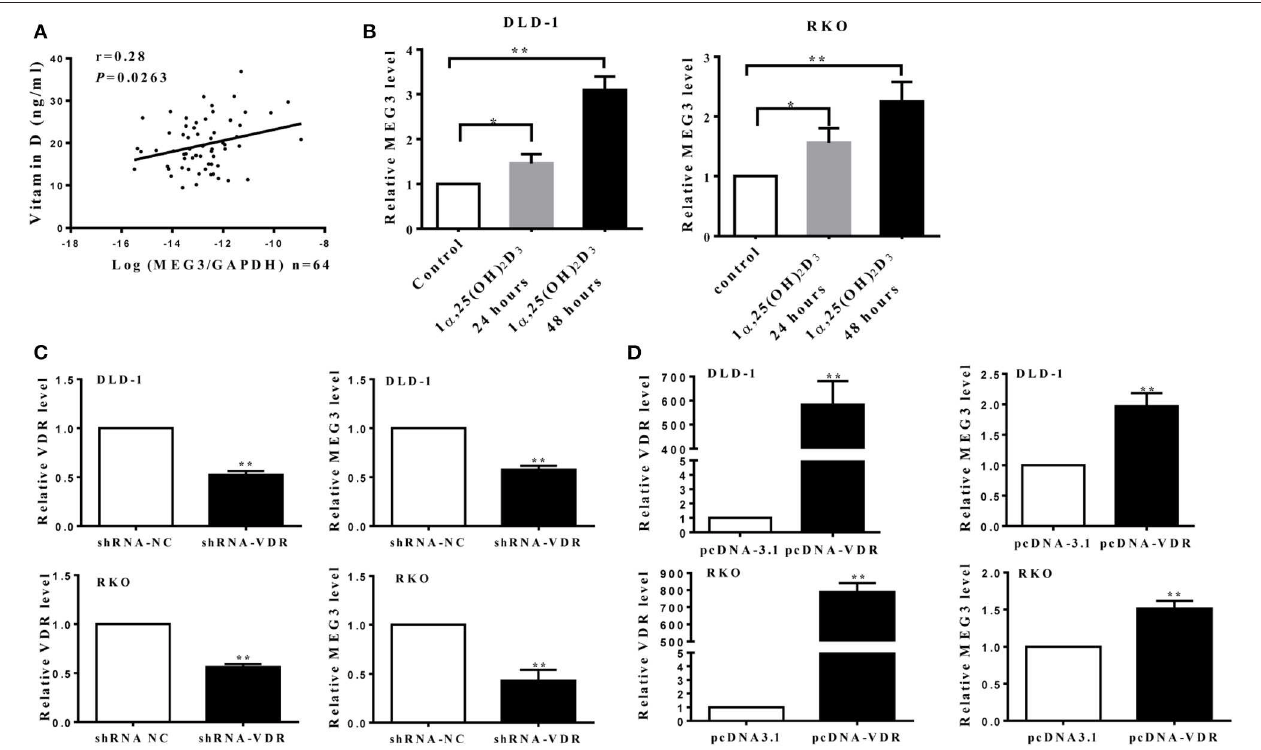
FIGURE 5 | Maternally expressed gene 3 ( MEG3 ) is activated by vitamin D through vitamin D receptor (VDR). (A) Levels of MEG3 expression in colorectal cancer (CRC) tissues and serum concentrations of vitamin D were examined in 64 CRC patients, and the correlation between MEG3 and vitamin D was analyzed. (B) MEG3 expression was measured with qRT-PCR after treatment with active vitamin D of 1 α ,25(OH) 2 D 3 (20nM) at the indicated times. MEG3 expression was detected by qRT-PCR in CRC cells transfected with shRNA-VDR (C) or pcDNA-VDR (D) . Data are expressed as mean ± standard deviation from three independent experiments. * P < 0.05, ** P <